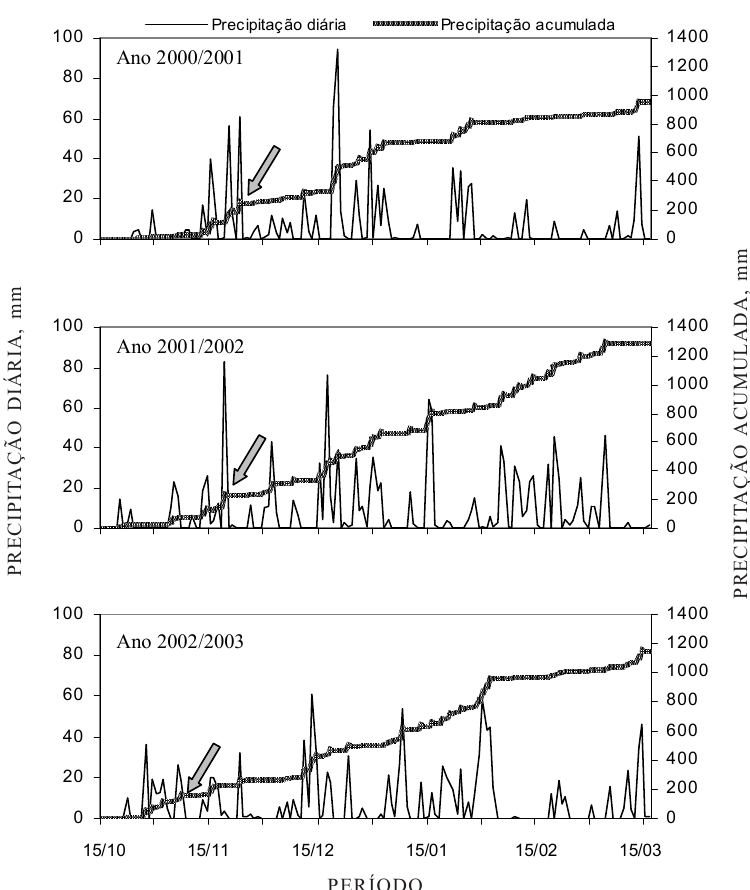
Figura 1. Dados pluviométricos referentes aos períodos dos três cultivos de milho (as setas indicam a época da